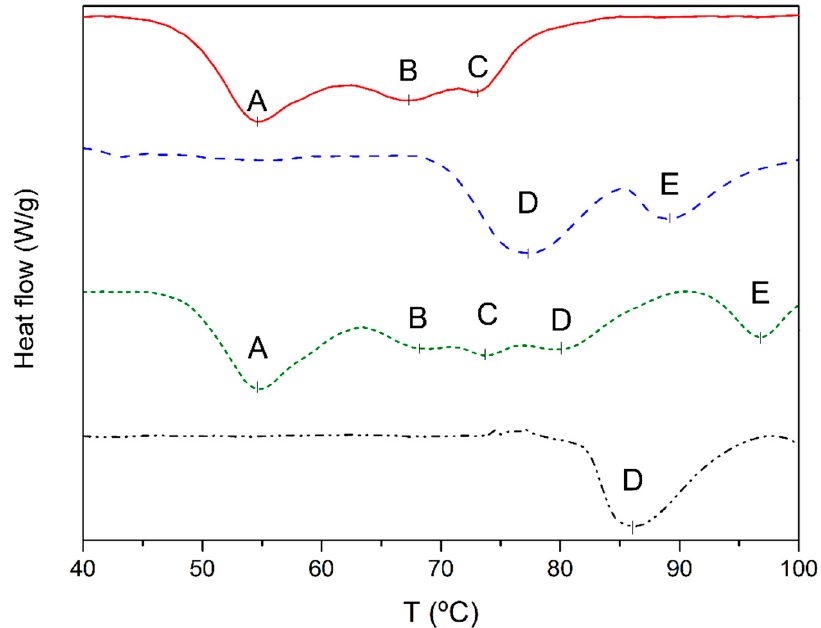
Figure 3. DSC normalized traces of pork meat/salts mix ( — ), bean flour (----), and raw ( ....... ) and